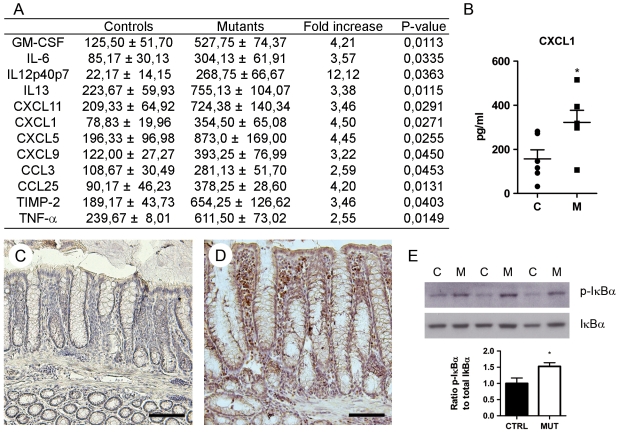
Increased cytokine and chemokine secretion associated with the inflammatory state of Hnf4α colon null mice.(A) Summarized results (means ± SEM; at least 3 individuals aged of 12 months) of the semi-quantitative cytokine/chemokine array shown in Table S1. (B) ELISA performed on total protein lysates (means ± SEM; n = 6 per group). (C) Labelling of granulocytic cells by MPO immunohistochemistry was negative in controls as opposed to (D) mutants. Scale bars, 100 µm. (E) Western blot of accumulated phospho-IκBα relative to total IκBα and relative quantification (mean ± SEM), *P≤.05.